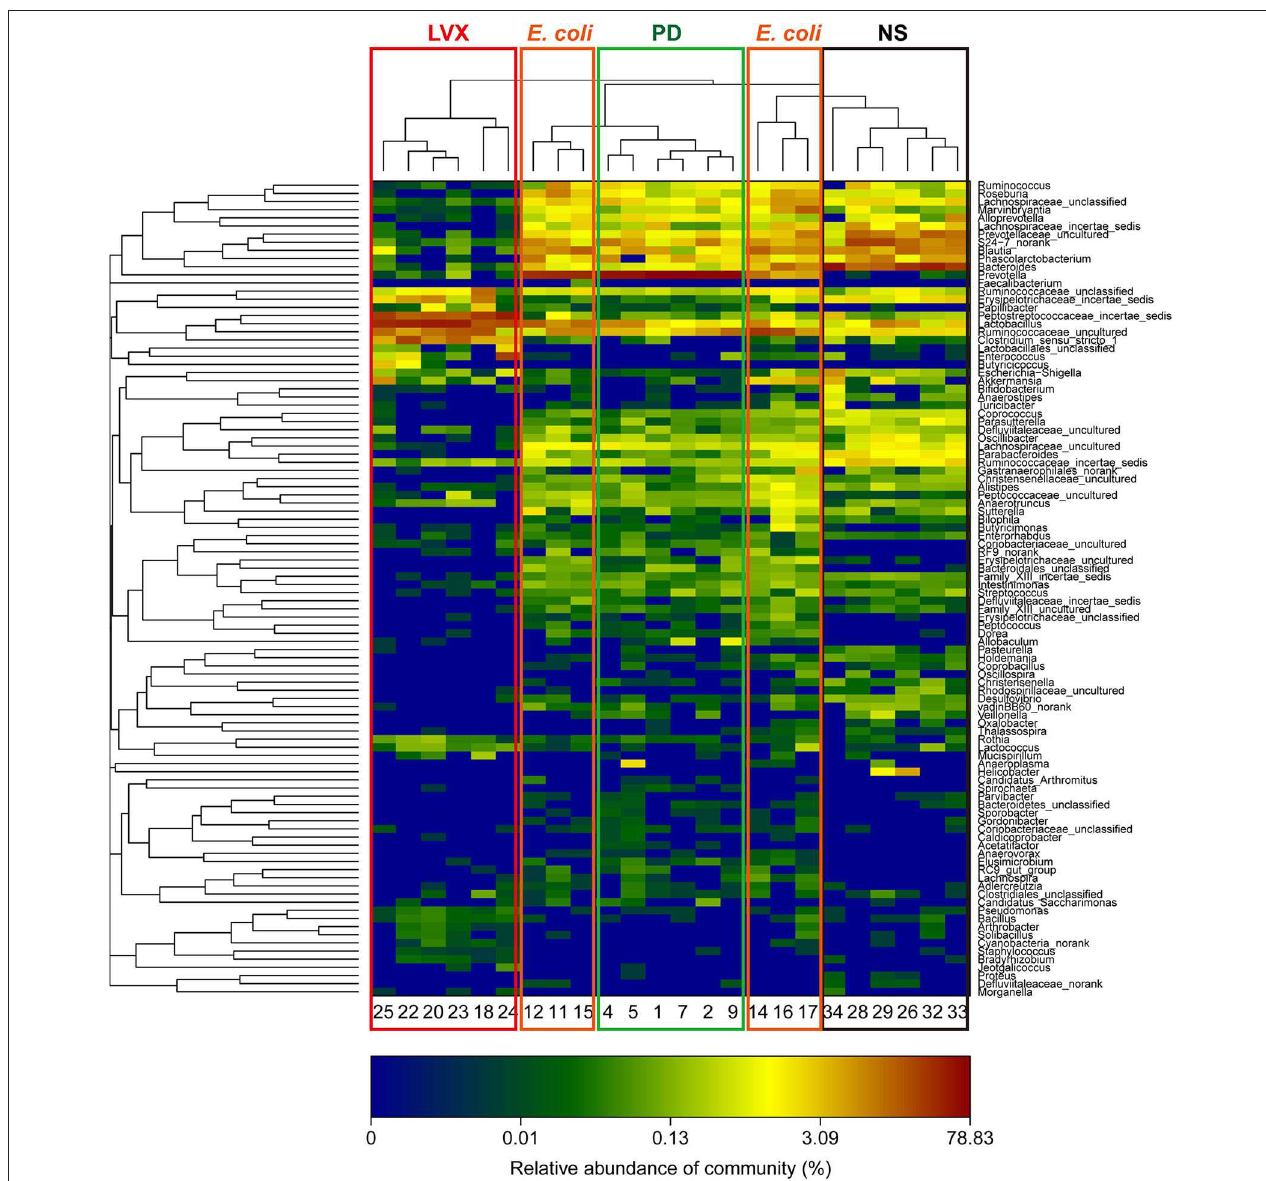
FIGURE 4 | Heatmap of hierarchy cluster indicated the amount of genus in feces. Colors reflect relative abundance from low (blue) to high